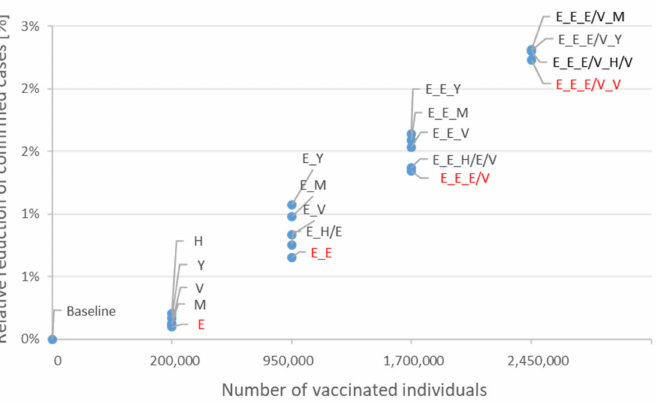
Figure A3. Cumulative relative reduction of confirmed cases for each stepwise optimization step for a vaccine inducing non-sterilizing immunity in comparison to no vaccination (maximizing relative reduction in deaths). E—elderly ( ≥ 65 years); H—healthcare workers; M—middle-aged persons (45–64 years); V—vulnerable, individuals with increased risk of severe disease once infected; and Y—persons of younger age (15–44 years). Vaccination strategies are described by stepwise provision of vaccines to population groups. For example, E_E_Y means that with the first batch 200,000 elderlies were vaccinated, followed by the second batch to vaccinate again 750,000 elderly and followed by the third batch to vaccinate 750,000 persons of younger age. A split of a batch among two population groups is symbolized by /. The strategy colored in red provided the best outcome in terms of relative reduction of deaths in the stepwise optimization as evaluated and displayed in Figure A1. The analysis assumed a vaccine effectiveness of 70% in the general population and of 60% in the age group